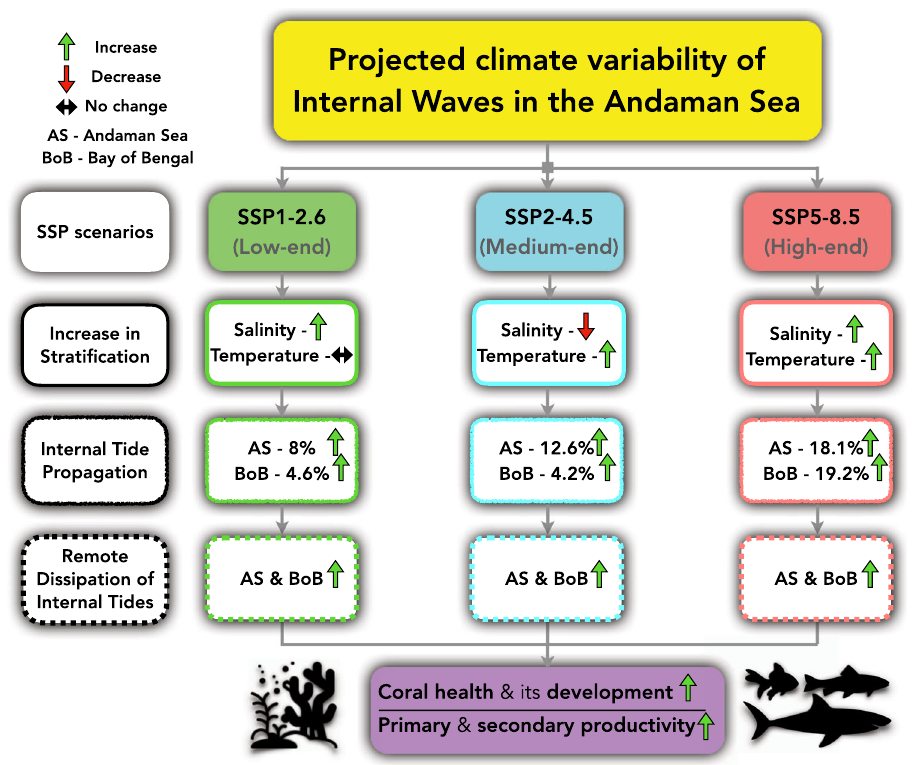
Fig. 7 Schematic diagram summarising the projected climate variability of internal waves in the Andaman Sea. The second row represents the different SSP scenarios. The effect of salinity and temperature on the increasing strati fi cation trend is shown in the third row. The ‘ increase ’ ( ‘ decrease ’ ) sign in this column indicates that the salinity/temperature changes contribute to an increase (decrease) in strati fi cation. The ‘ no change ’ icon indicates that the salinity/temperature has little to no effect on changing strati fi cation. In the fourth and fi fth row, the increase in the IT propagation into the Andaman Sea (AS) and Bay of Bengal (BoB) and subsequent increase in remote dissipation simulated by MITgcm between the present (2015 – 2024) and the end-century (2091 – 2100) is shown. The potential implications are shown in the sixth and fi nal